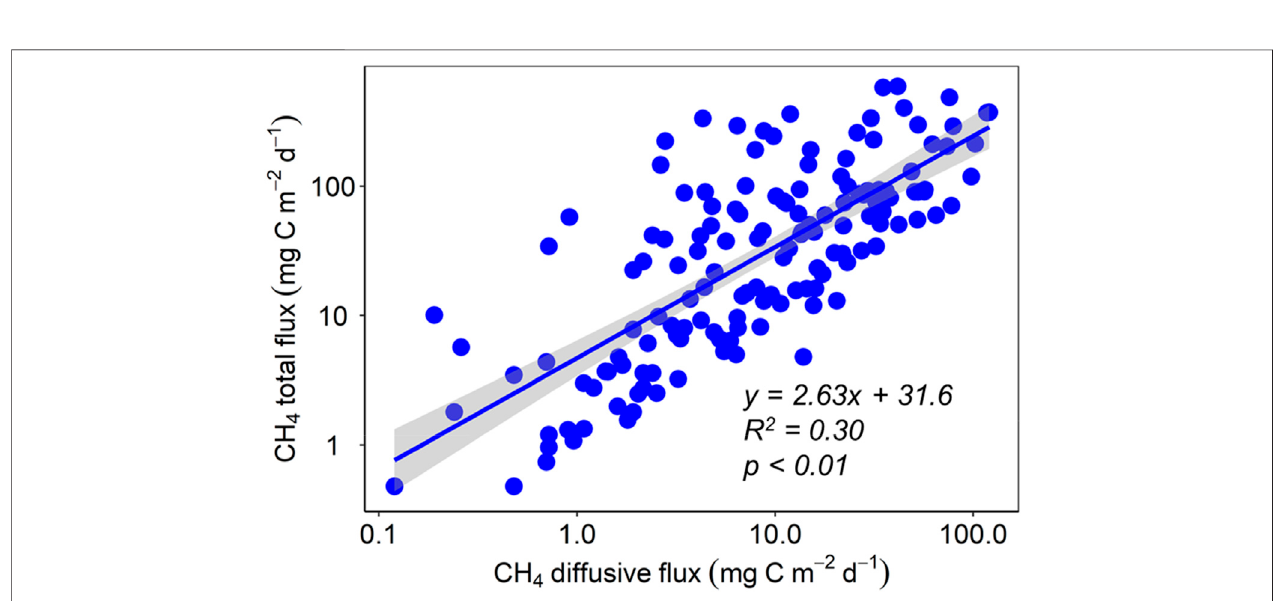
FIGURE2| RelationshipbetweentotalCH 4 fl ux(diffusiveandebullitive)anddiffusive fl ux.ThisrelationshipwasderivedonthebasisofthedatasetofDelSontroetal. (2018), i.e., 96 records, and that of Deemer et al. (2016), i.e., 50 records.